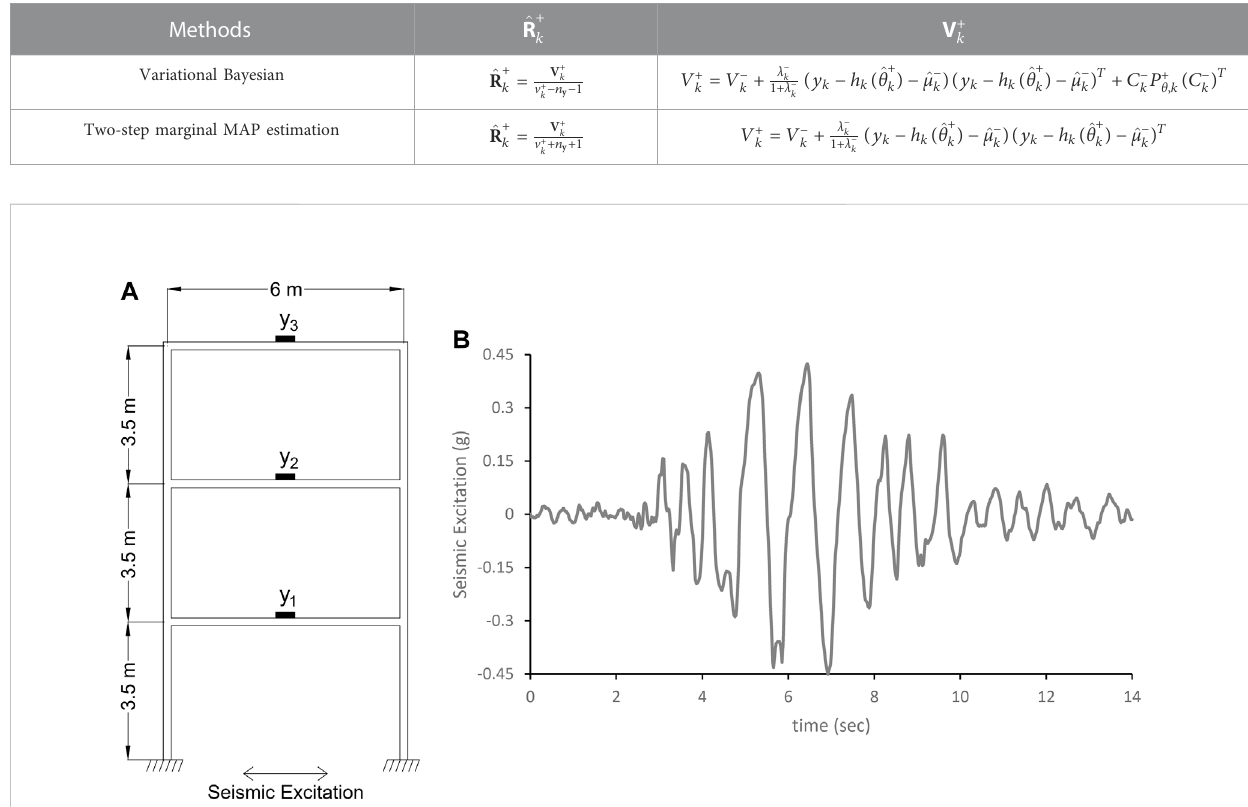
FIGURE 2 (A) 3-story 1-bay steel moment frame and (B) 0 ° component of ground acceleration time history of the Loma Prieta earthquake recorded at Los Gatos station (Nabiyan et al., 2022).